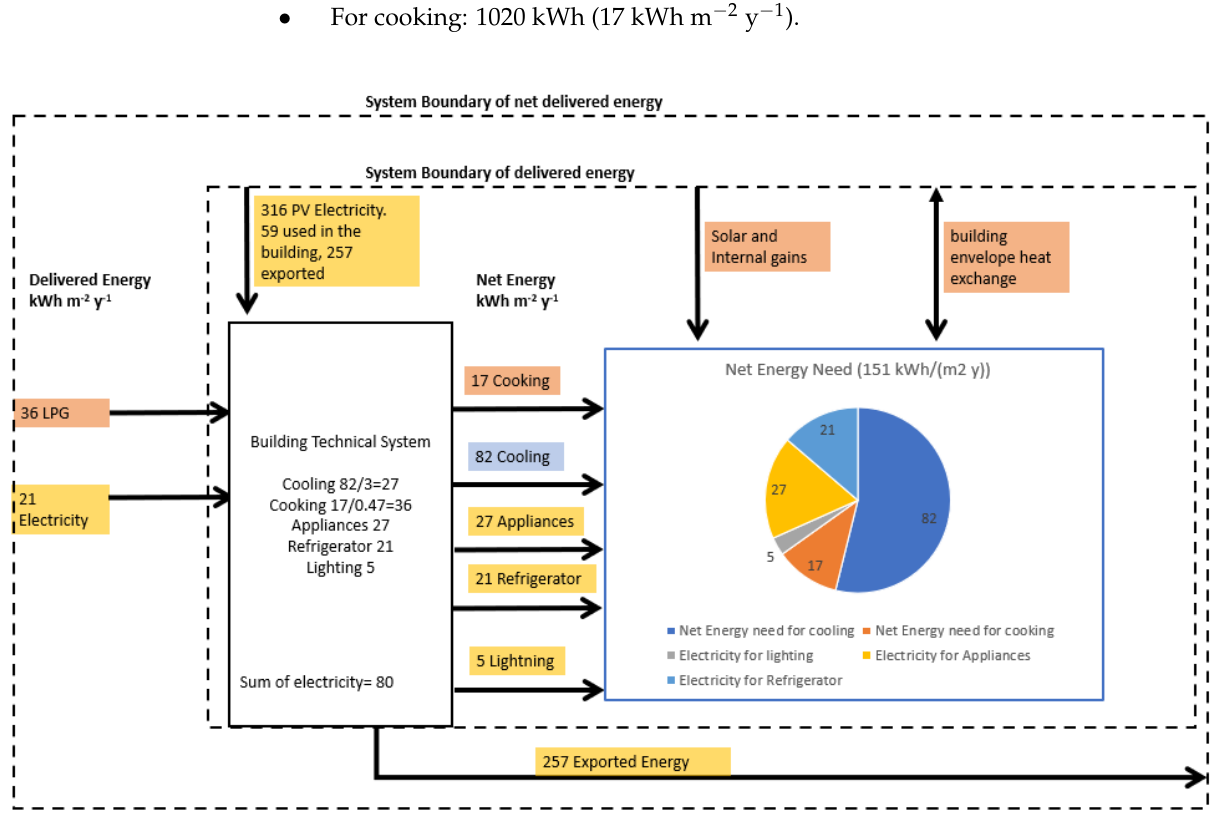
Figure 12. Case study: boundary system example for the case study with the 60 m 2 dwelling.